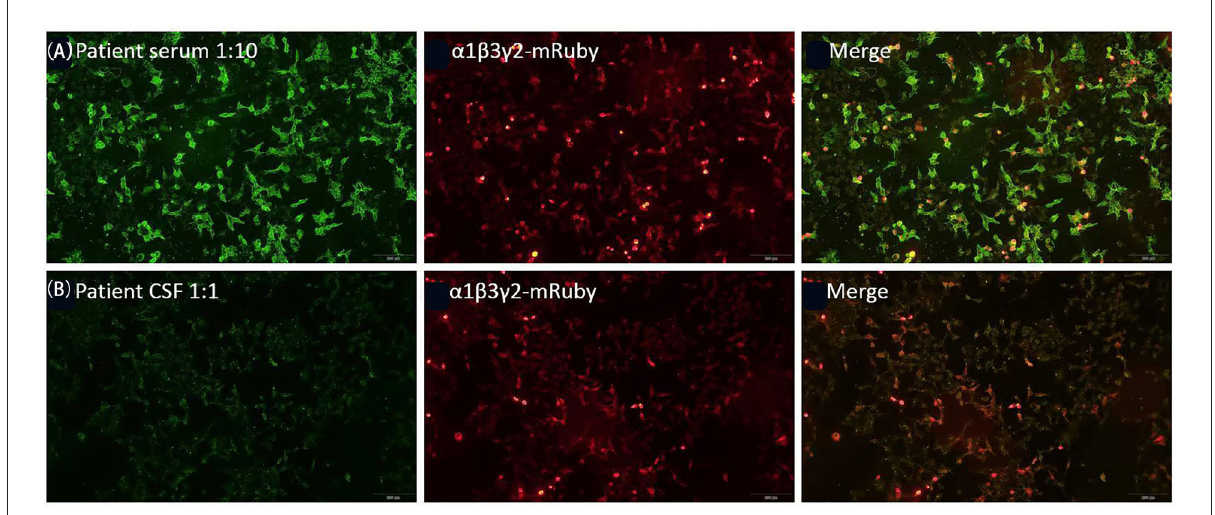
FIGURE3 Reactivity of the patient’s serum (A) and cerebrospinal fluid (CSF) (B) with live HEK293 cells expressing human α 1/ β 3/ γ 2 subunits of GABA A R.